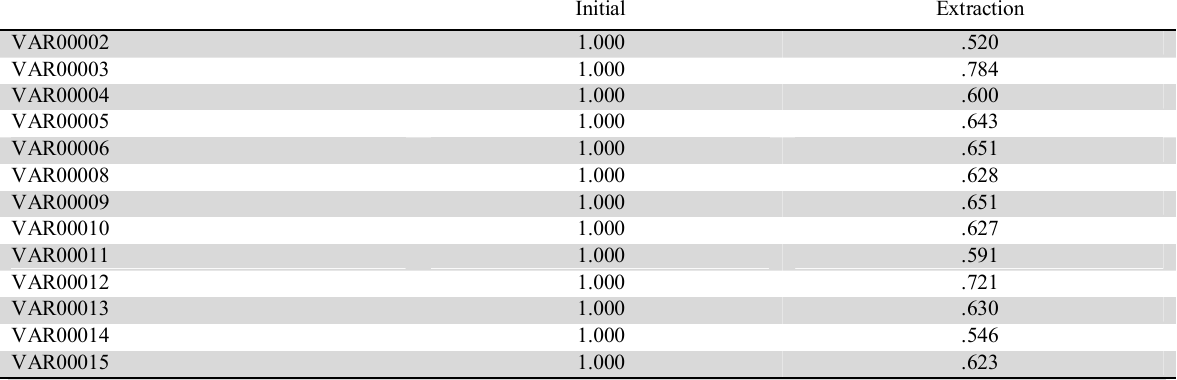
The results of communalities